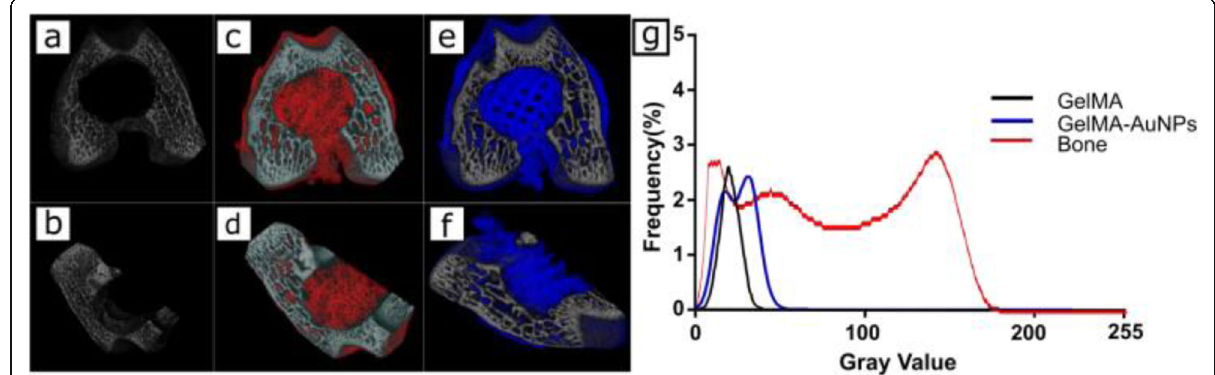
Fig. 3 CT tomogram of mouse bone injury area ( a - f ). Empty group( a - b ), GelMA group( c - d ), GelMA-AuNPs group( e - f ). Comparison of the radiopacity of the three experimental groups( g ). Reproduced with permission [89]. Copyright (2019),